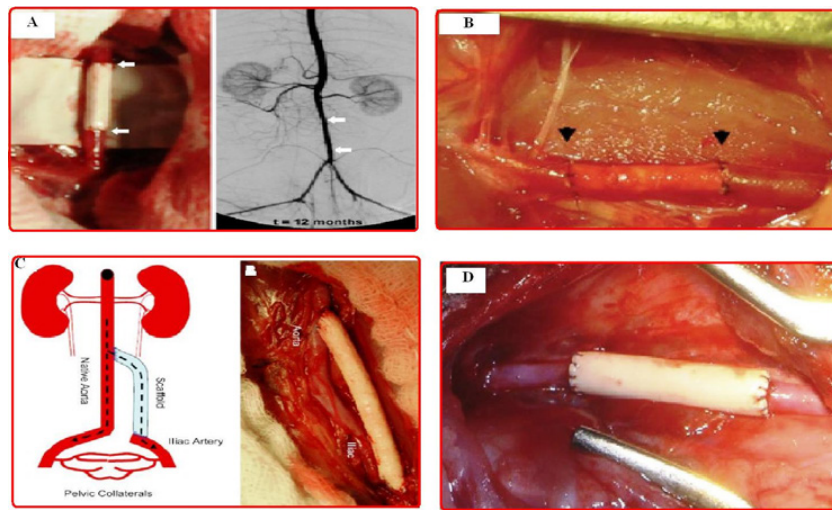
Figure 3 : A) PCL nano ― fibrous scaffold implanted in Rat ― aorta, B) PCL ― CAG peptide nano ― fibrous scaffold implanted in Rat ― carotid, C) PCL ― Collagen nano ― fibrous scaffold implanted in Rabbit ― aortic ― bypass, D) PCL ― Elastin nano ― fibrous scaffold implanted in Rabbit ―